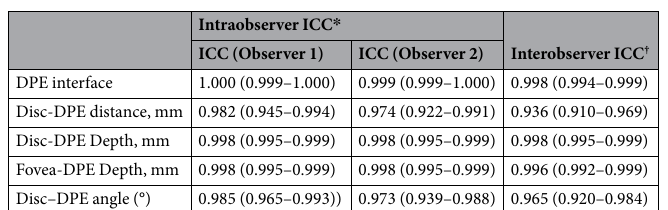
Table 1. Reproducibility of the measurements of the deepest point of the eyeball interface, Disc-DPE distance, Disc-DPE depth, Fovea–DPE depth, and Disc-DPE angle using swept-source optical coherence tomography in emmetropic and myopic eyes. DPE: deepest point of the eyeball; ICC: intraclass correlation coefficient. * ICC for single measure. † ICC for average